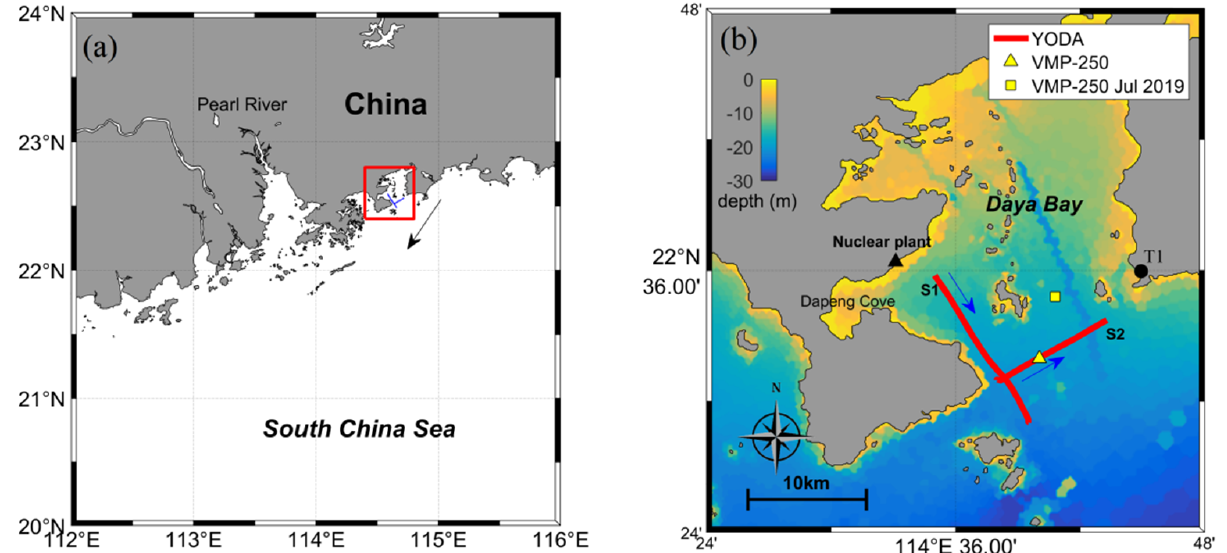
Figure 2. ( a ) Location of Daya Bay (DYB) along the southern coast of China. The arrow indicates the sea wind direction. ( b ) Bathymetric map of DYB, in which S1 and S2 indicate the two YODA observation transects (red lines). The yellow triangle and square indicate the locations of VMP-250 profiler observations and the blue arrows indicate vessel route directions. T1 (black circle) is the observation station of tidal elevation.